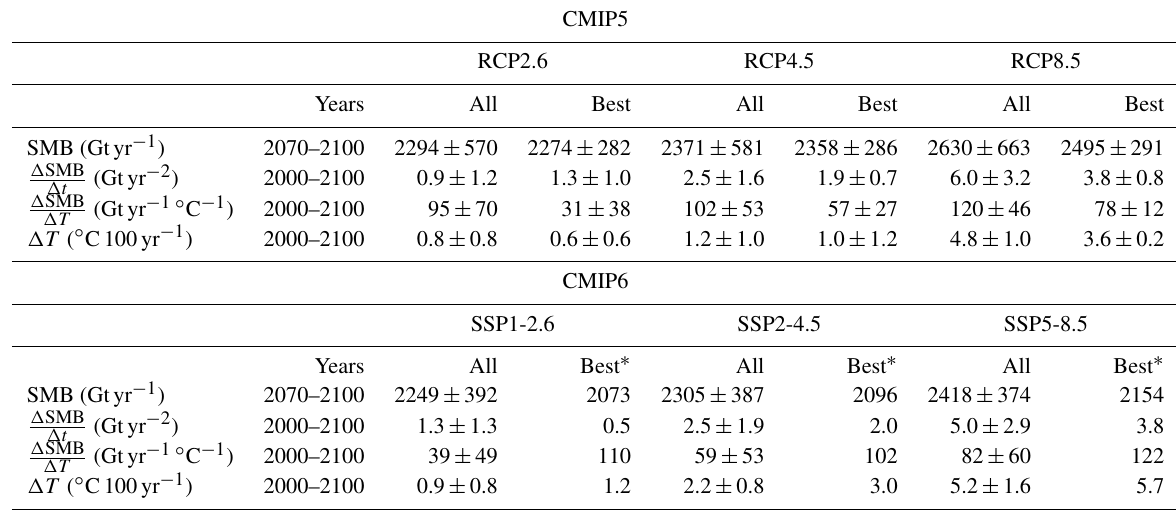
Table 2. Projected values for SMB, SMB trend, SMB temperature sensitivity, and change in 21st century temperature for all CMIP5 and CMIP6 models compared to the best scoring CMIP5 models for RCP2.6, RCP4.5, and RCP8.5 and best scoring CMIP6 models for SSP1-2.6, SSP2-4.5, and SSP5-8.5.